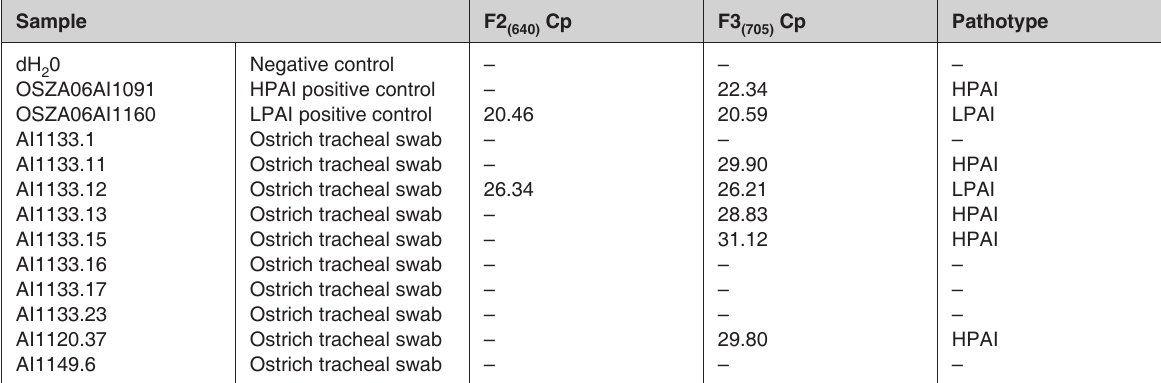
TABLE 2 Results of the H5 rRT-PCR pathotyping assay